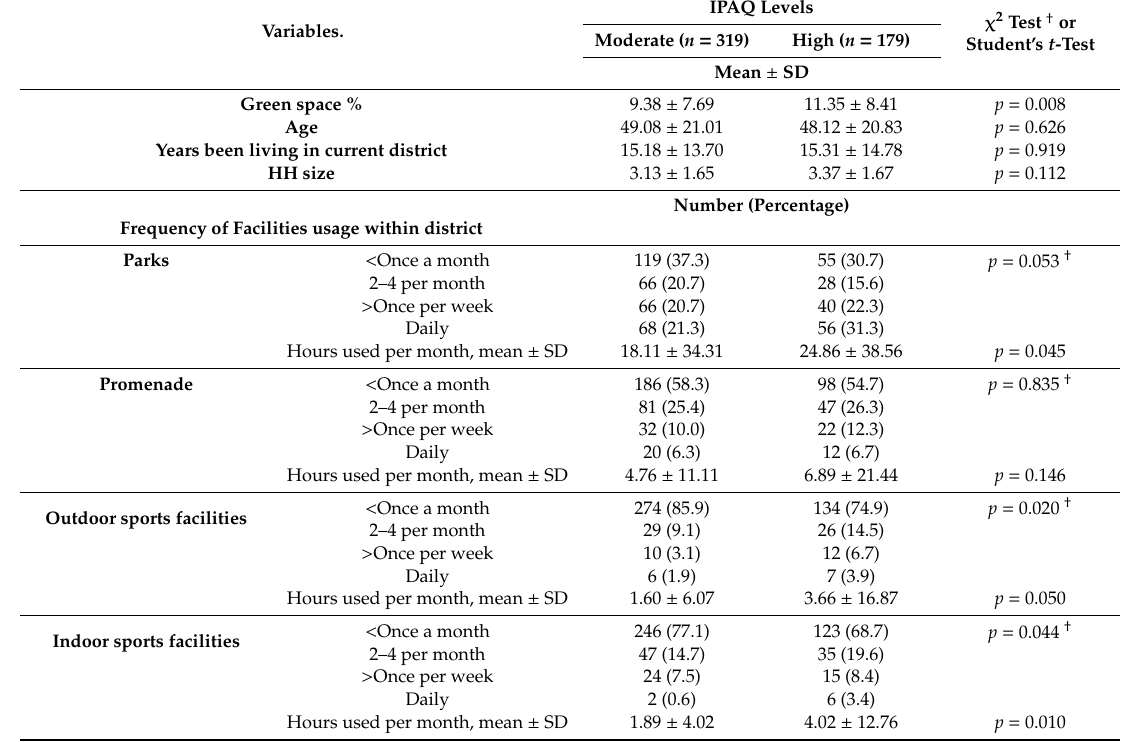
Table 6. Comparison of the usage of within and nearby district facilities among moderate and high IPAQ level